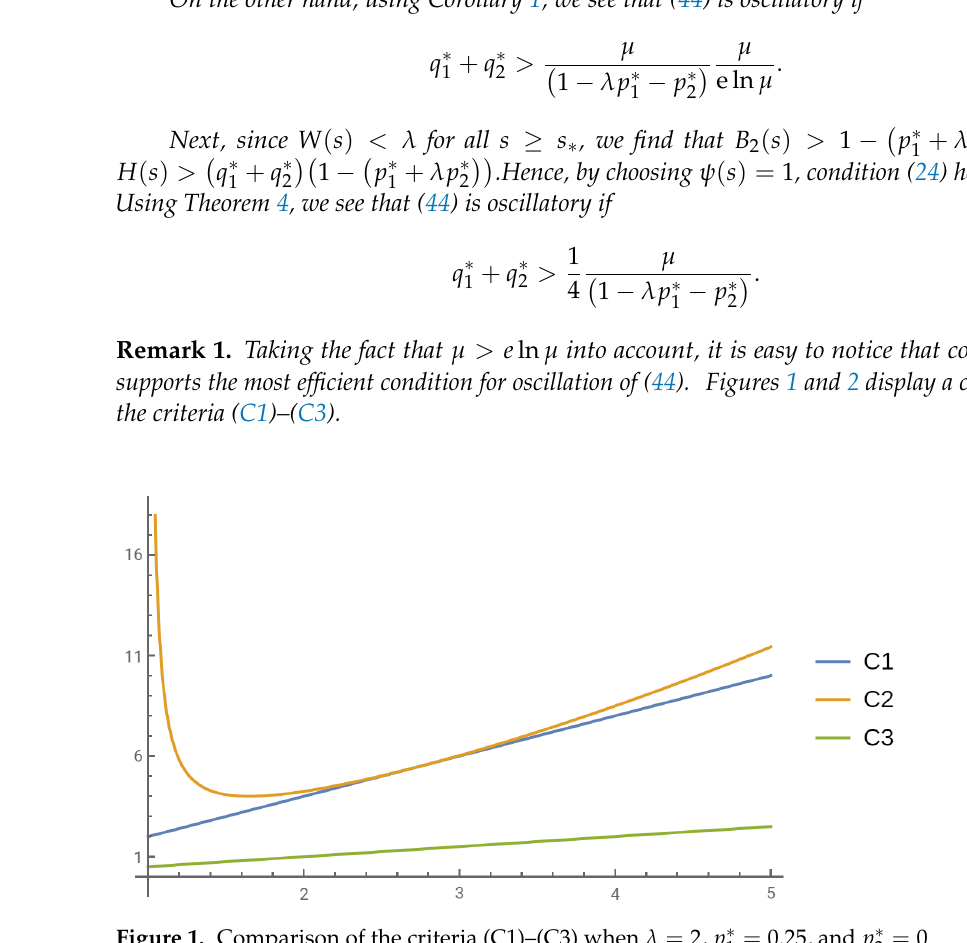
Figure 1. Comparison of the criteria (C1)–(C3) when λ = 2, p ∗